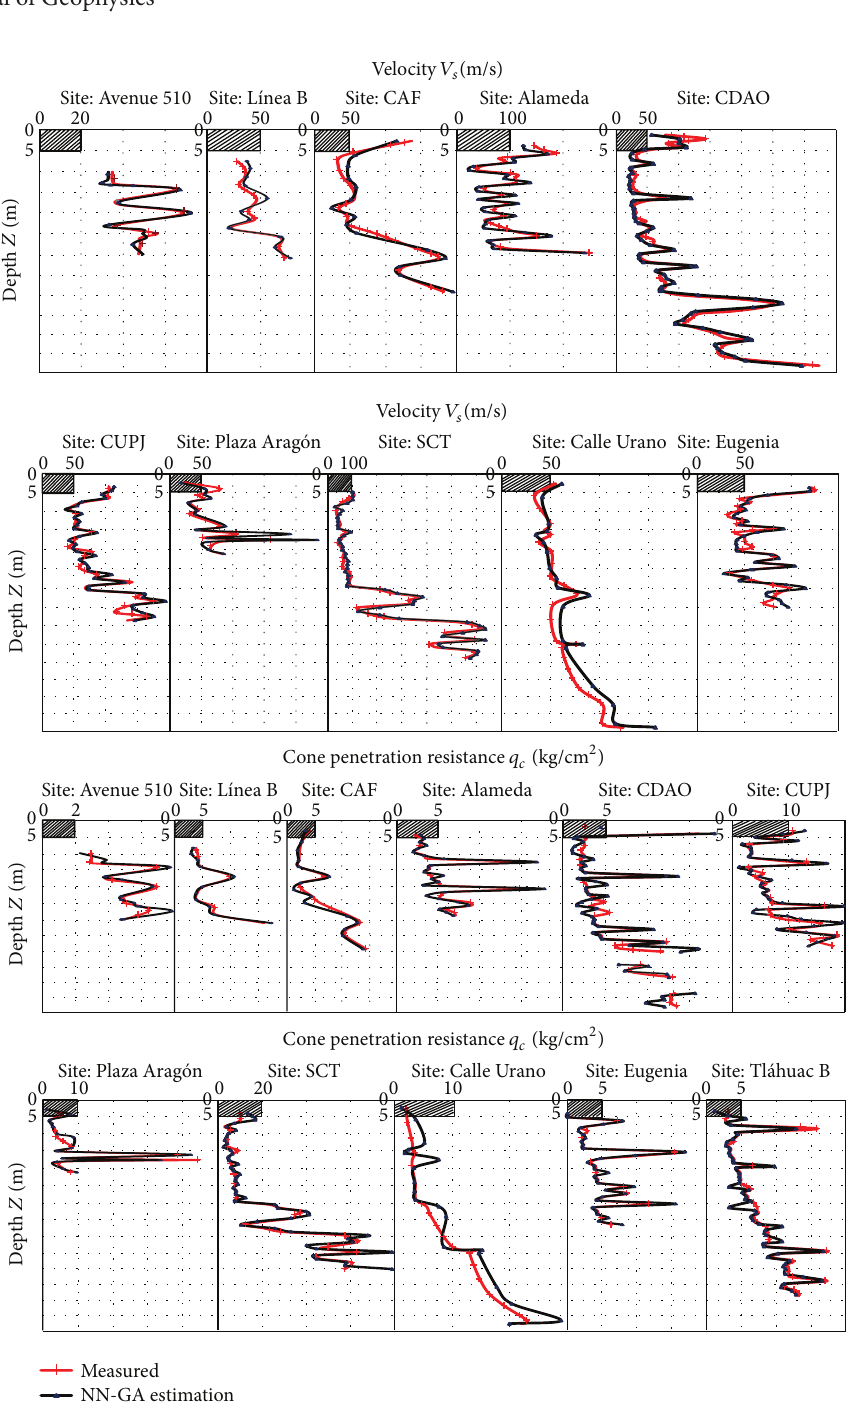
Figure 7: Neural 𝑉 𝑠 and 𝑞 𝑐 vectors compared with in situ